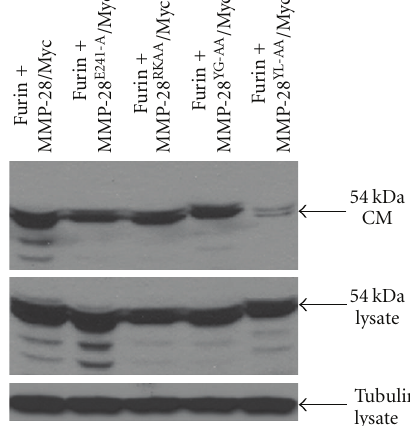
(d) Western blotting of the conditioned medium and cell lysate using anti-Myc antibody: COS-1 cells weretransfectedwithfurinalongwithwildtypeand mutant MMP-28. The conditioned medium and cell lysate were examined by Western blotting using anti-Myc antibodies. An aliquot of total cell lysate for α/β tubulin was used as a loading control